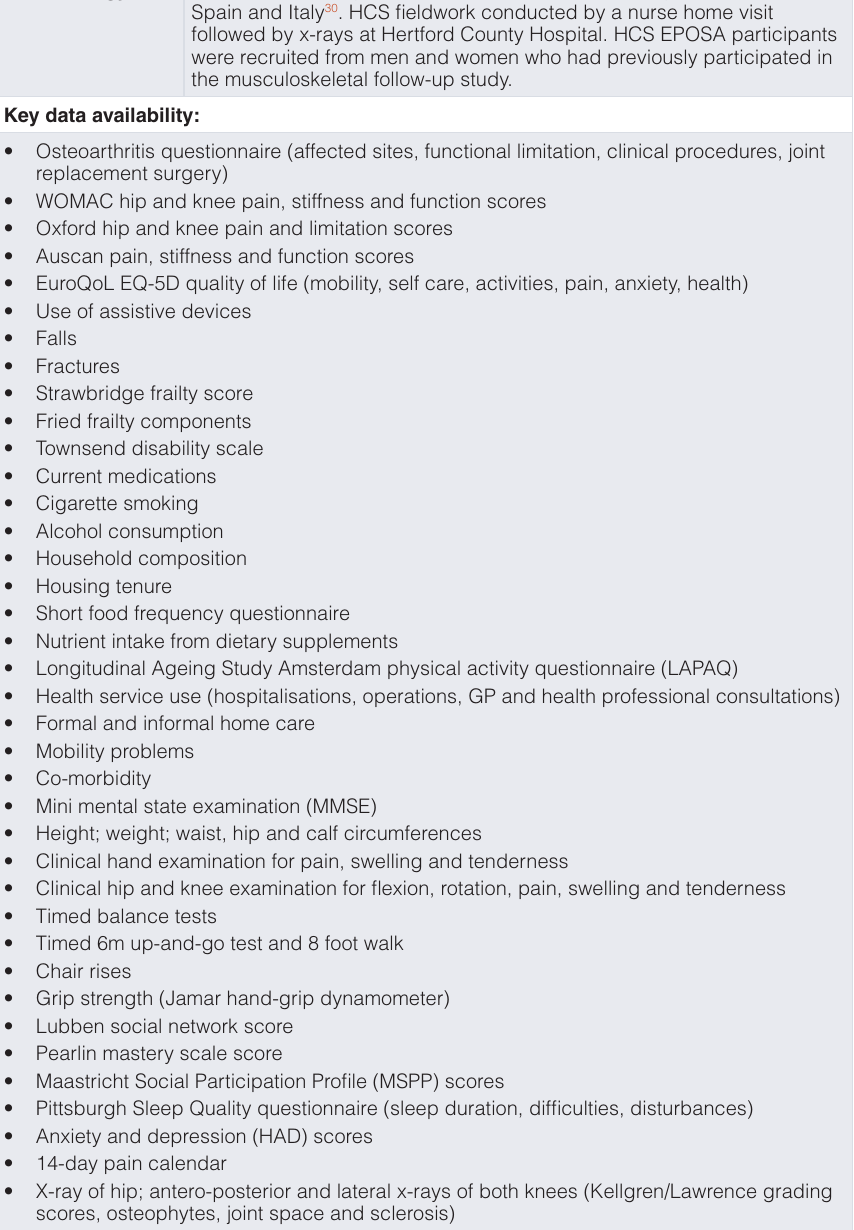
Table 8. Hertfordshire Cohort Study component of the European Study of Osteoarthritis (EPOSA). Objective: To identify risk factors for, and consequences of, osteoarthritis (OA) for individuals and society and to explore cross-country differences in these